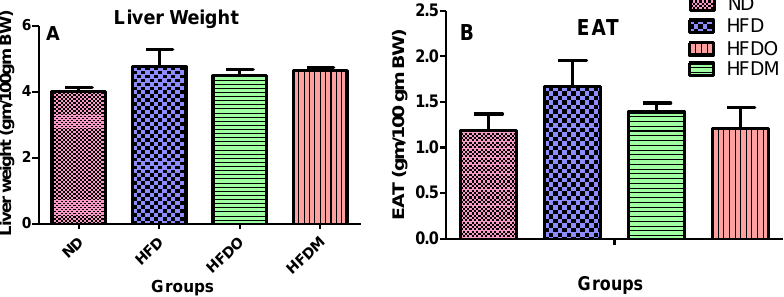
Figure 6. Comparison of liver and epididymal adipose tissue (EAT) weights among various groups. MESK treatment reduced ( A ) the liver weight and ( B ) the epididymal adipose tissue weight. Data are represented as Mean ± SD. (ND: normal diet, HFD: high-fat diet, HFDO: HFD + Orlistat, HFDM: HFD + MESK).